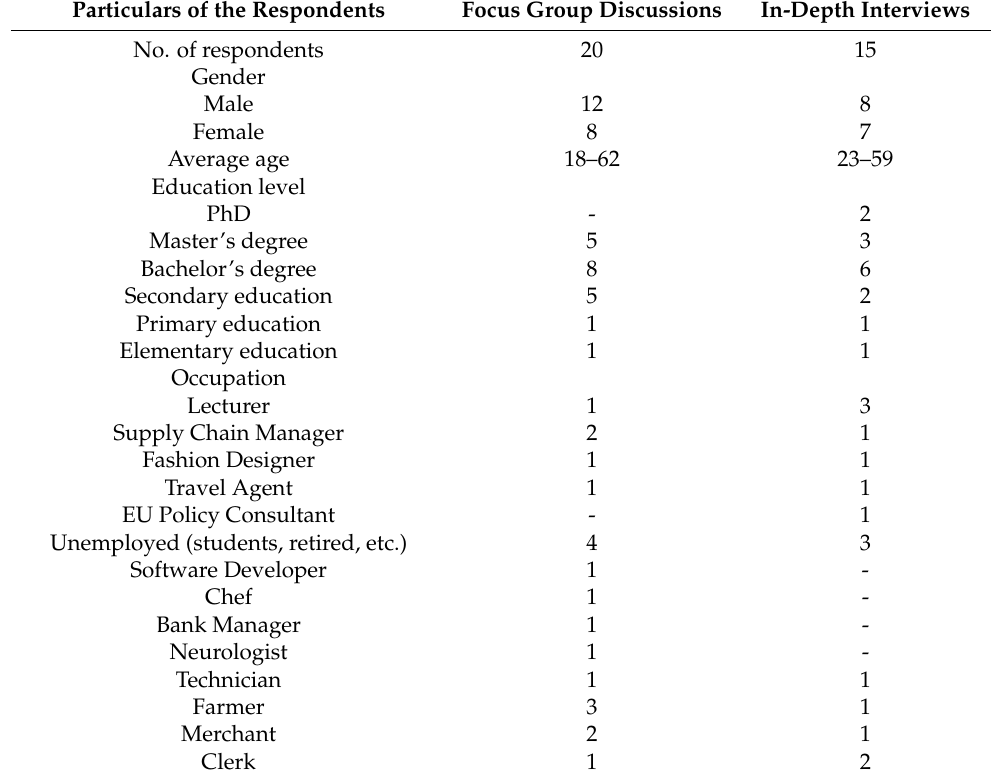
Table 2. Demographic characteristics of the focus group discussion and in-depth interview